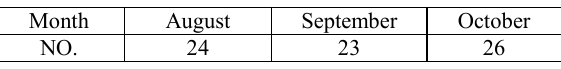
Table1. Valid data pairs for AOD and